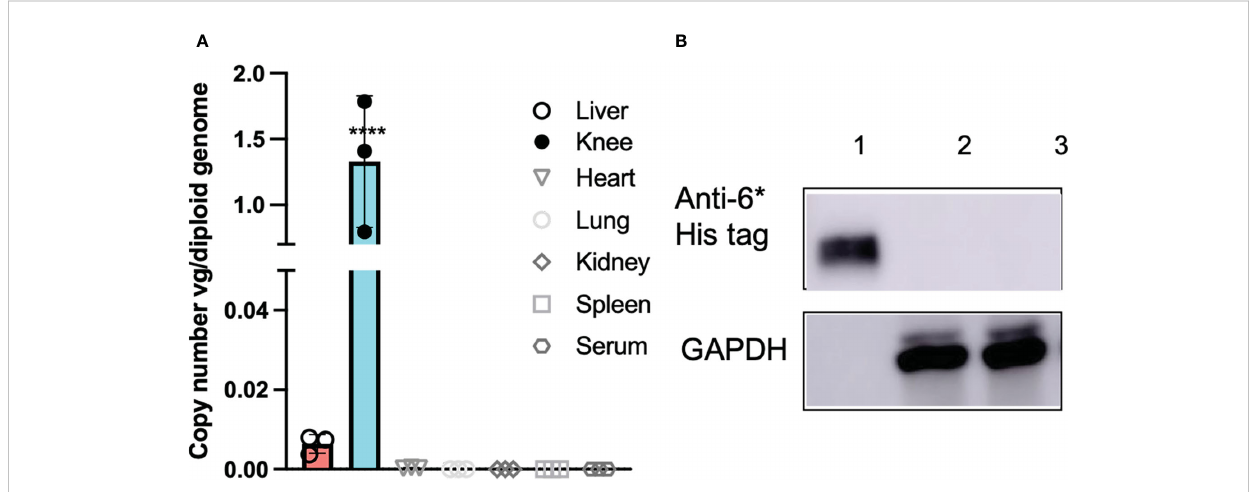
FIGURE 7 No systemic side effects detected after intraarticular AAV5/PD-L1 injection. (A) , AAV genome copy numbers. At week 7 after AAV injection, mice were euthanized and different tissues (liver, knee, heart, lung, spleen and kidney) were collected for AAV genome analysis using qPCR. DNA from the heart, liver, spleen, lung, kidney, and knees from mice injected with AAV5/PD-L1 were extracted using DNeasy Blood & Tissue Kits and then determined by qPCR. The data represent the mean and standard derivation (n=3). ****, p < 0.001. (B) , Western blot of PD-L1 in liver lysates. 20 m g of supernatant from the liver lysates collected from mice injected with AAV5/PD-L1 and PBS were loaded in SDS-PAGE to detect PD-L1 protein by western blot using mouse anti-6*His tag antibody. Lane 1, recombinant PD-L1-his protein, lane 2, AAV5/PD-L1 treated mice liver, lane 3, PBS treated mice